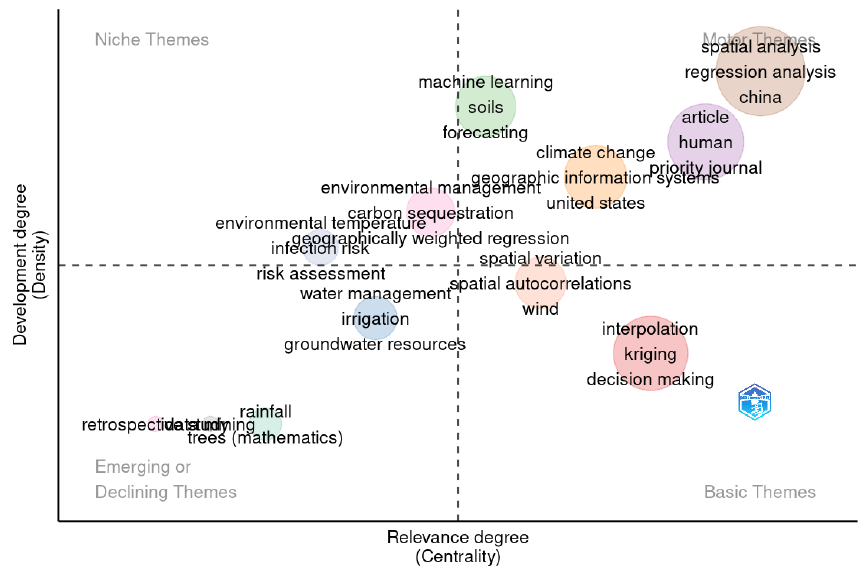
Fig. 6. Thematic map of Dataset